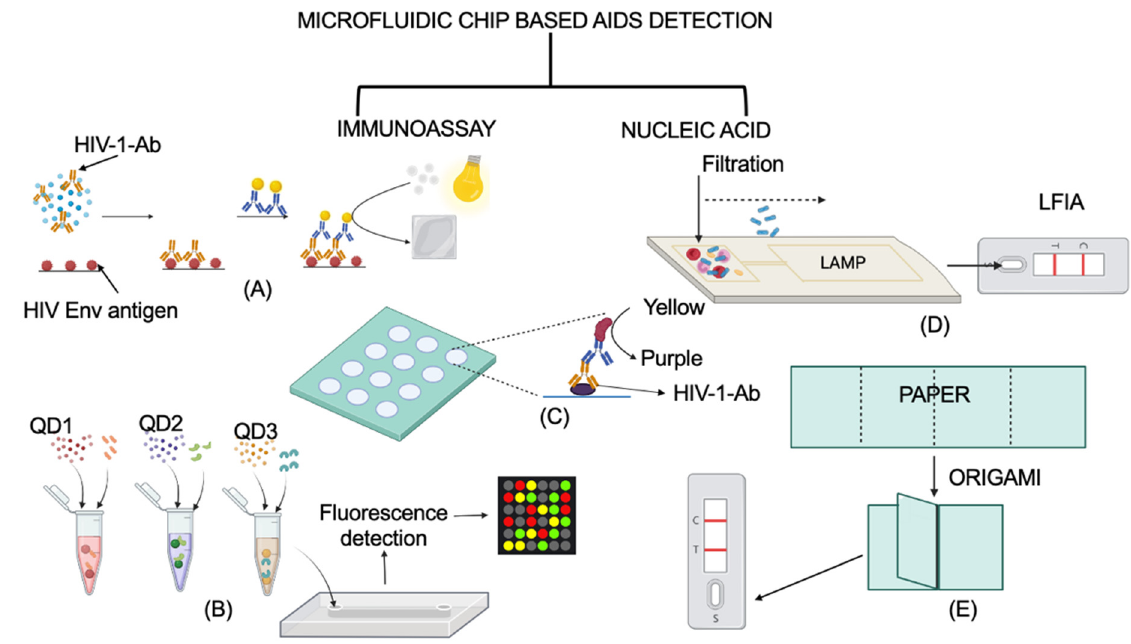
Figure 8. A schematic representation of two types of microfluidic chip biosensors for the detection of AIDS. ( A – C ) are categorized as immunoassay-based microfluidic chip biosensors, while ( D ) and ( E ) are nucleic-acid microfluidic chip biosensors. ( A ) POCKET immunoassay . Adapted from ref. [92]. ( B ) QD-based immunoassay . Adapted from ref. [93]. ( C ) Paper-based ELISA . Adapted from ref. [94]. ( D ) LAMP and LFIA-based sensing . Adapted from ref. [95]. ( E ) Origami-based isothermal, enzymatic amplification of HIV DNA and LFIA sensing . Adapted from ref. [96]. The representation of a working principle in this figure is to explain the mechanism. The original research article rep- resentation of these chips may vary from the one shown in the figure. Created using BioRender.com.